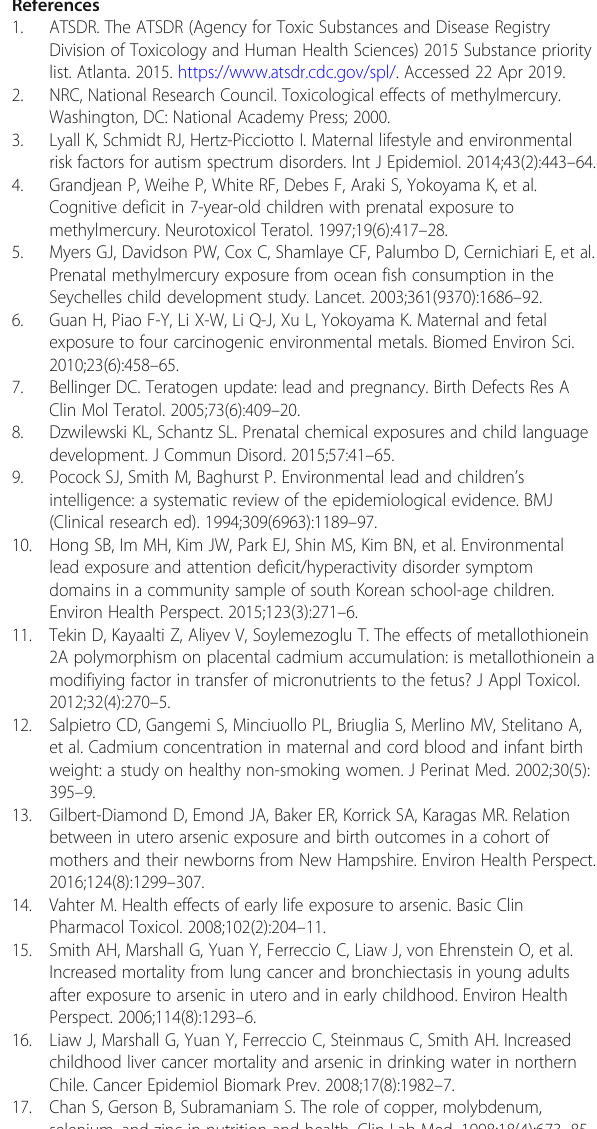
Figure S2. Correlations of blood mercury concentrations between A laboratory (International mercury lab) and B laboratory (IDEA